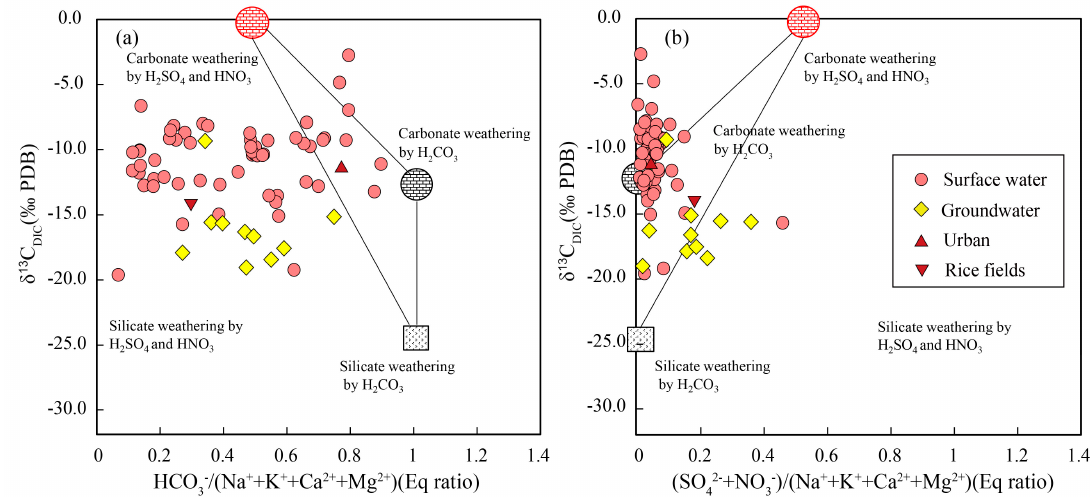
Figure 5. ( a ) δ 13 C DIC vs. HCO 3 − /(Na + + K + + Ca 2+ +Mg 2+ ) and ( b ) (SO 42 − + NO 3 − )/(Na + + K + + Ca 2+ Mg 2+ ). Figure based on Liu, Xu, Sun, Zhao, Shi and Liu [48].